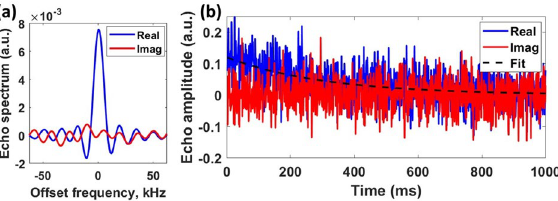
Figure 12. NQR features obtained for a psychoactive drug, namely benzocaine: ( a ) echo amplitude (a.u.), and ( b ) T 2, eff